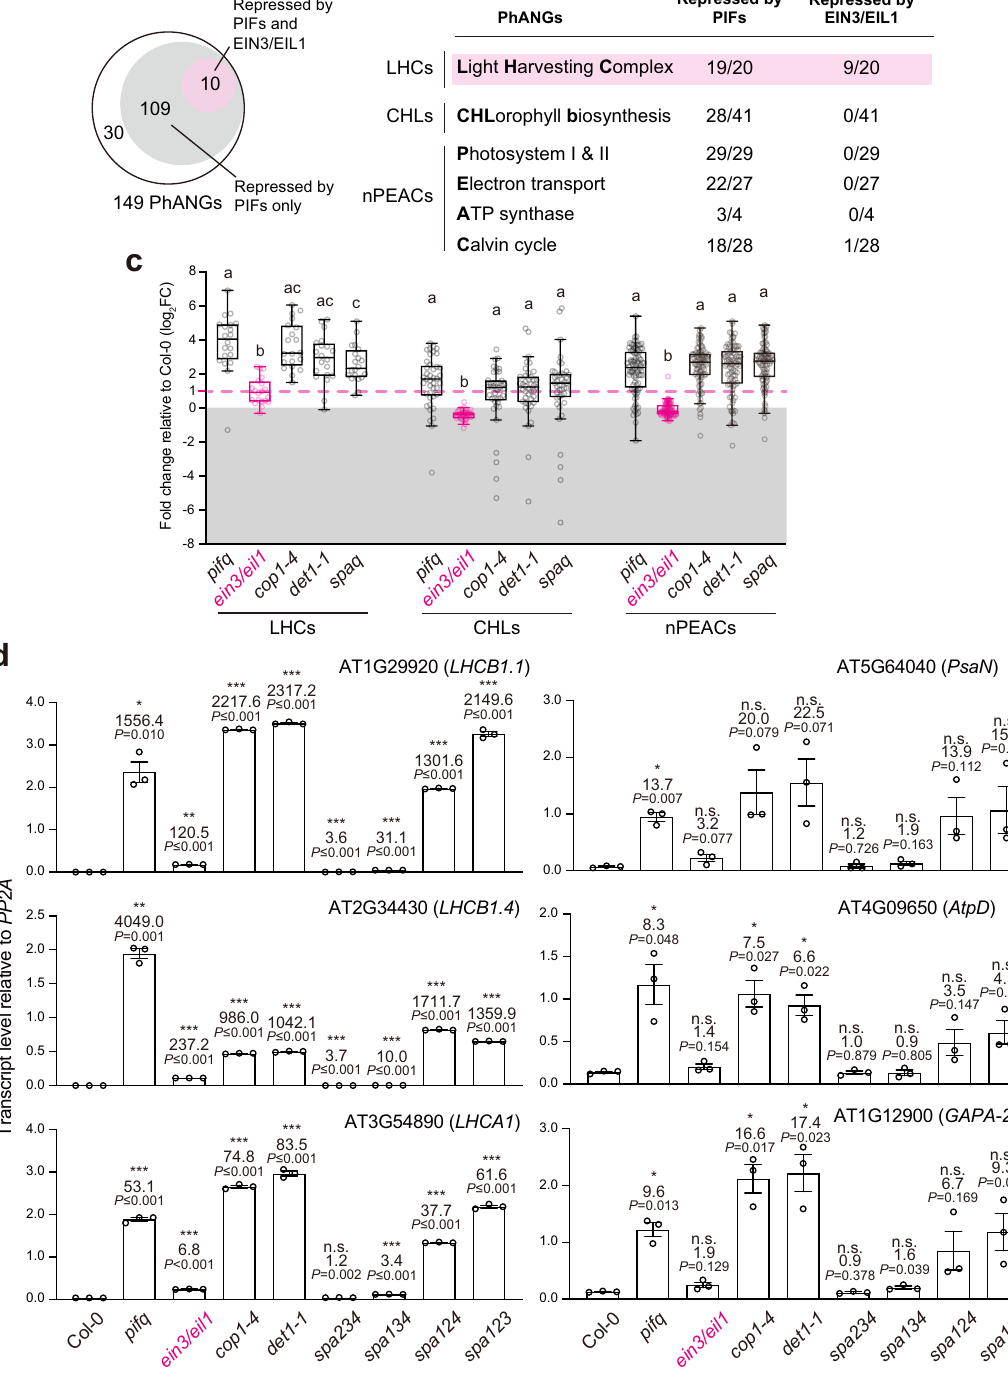
replicates for pifq , cop1-4 , det1-1 , and spaq , and n =2 biological replicates for ein3 / eil1 ). d qRT-PCRanalysisofthesteady-statetranscriptlevelsofrepresentative LHCs ( LHCB1.1 , LHCB1.4 , and LHCA1 ) and nPEACs ( PsaN , AtpD , and GAPA-2 ) in 4-d- old dark-grown seedlings of Col-0, pifq , ein3/eil1 , cop1-4 , det1-1 , spa234 , spa134 , spa124 , and spa123 . Thetranscript levelswerecalculated relative to those of PP2A . ThefoldchangesbetweenthetranscriptlevelsinthemutantsandCol-0areshown. Asterisks indicate statistically signi fi cant differences between the transcript levels of the mutant and Col-0 based on two-tailed Student ’ s t -test ( * P ≤ 0.05, ** P ≤ 0.01, *** P ≤ 0.001).If the change wasless thantwo-foldornot statistically signi fi cant, itis labeled as n.s. (not signi fi cant). Error bars represent the s.e. of three biological replicates,andthecentersoftheerrorbarsrepresentthemeanvalues.Thesource data underlying the statisticalanalysis in c and qRT-PCRanalysis in d are provided in the Source Data fi